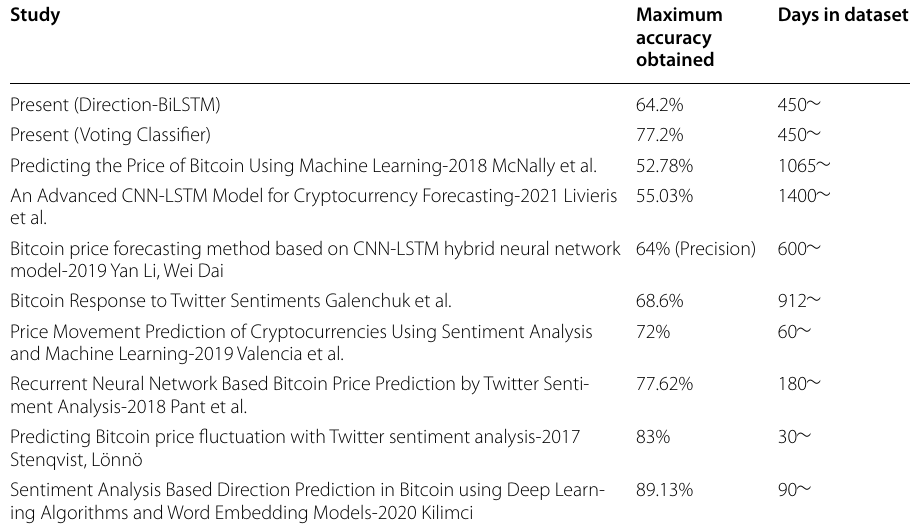
Table 6 Comparison with other studies Study Maximum